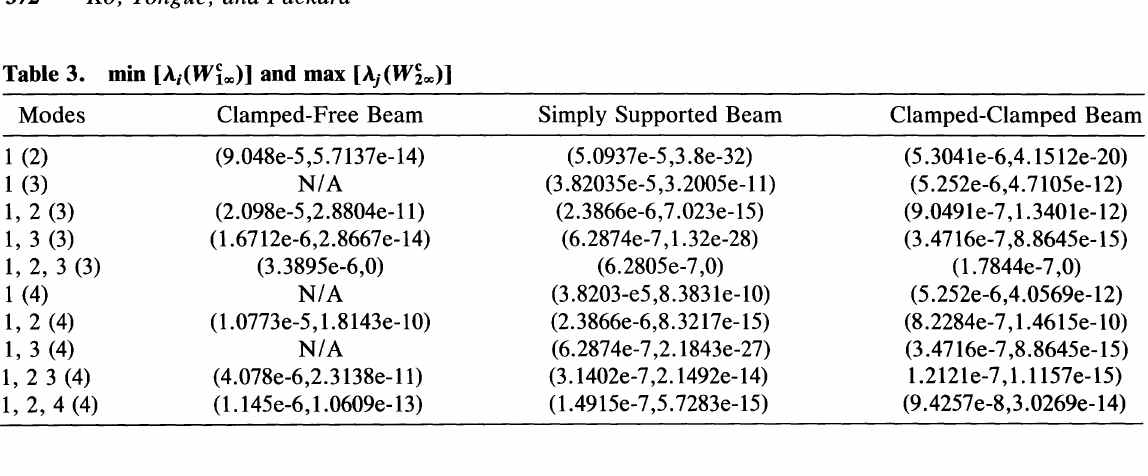
Table 3. min [A;(W~ .. )] and max [Aj(W~,,)] Clamped-Free Beam Simply Supported Beam